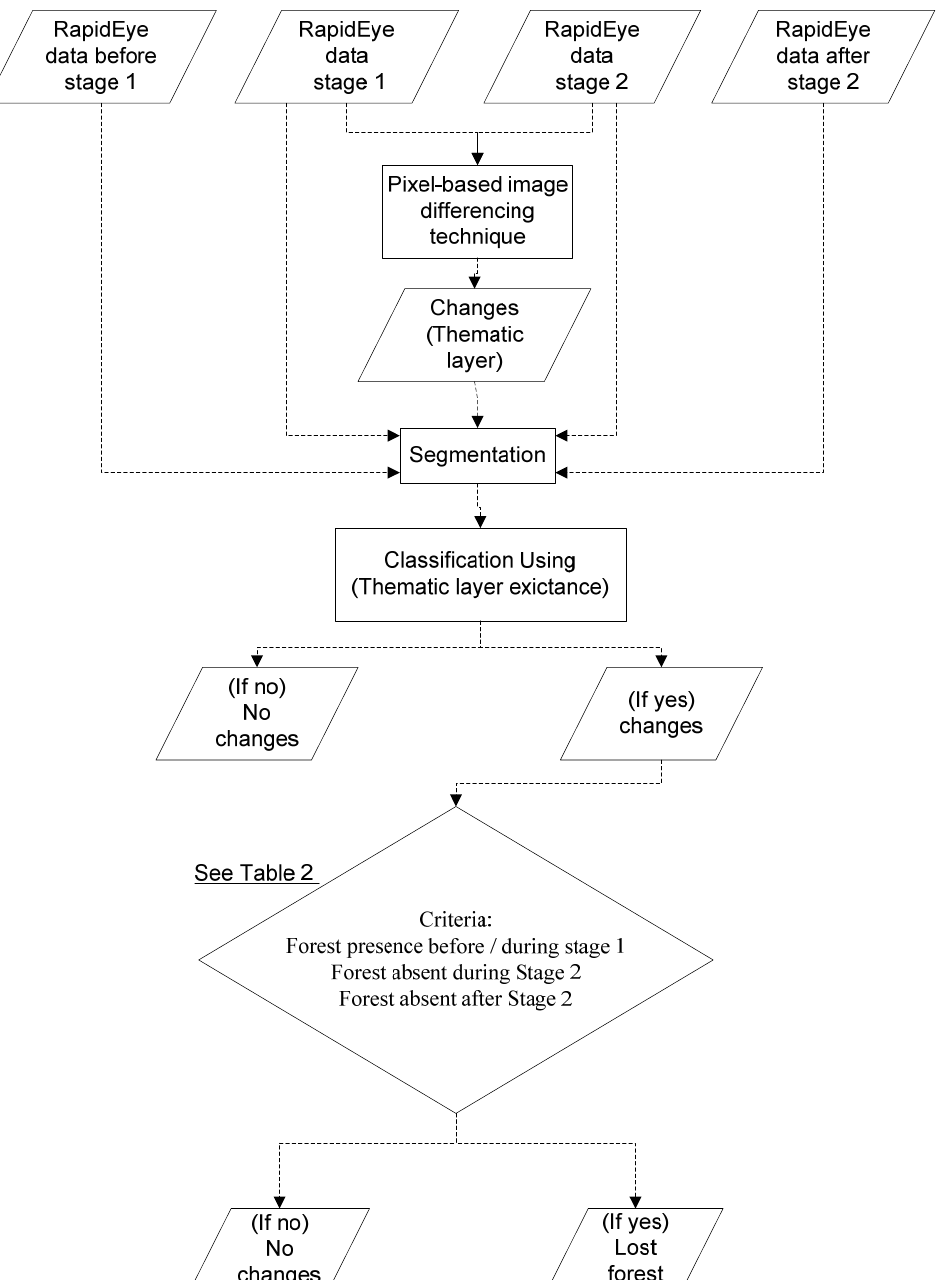
Figure 2. Overall methodology followed for the detection of loss in forest cover in the BFNP for the first period and second